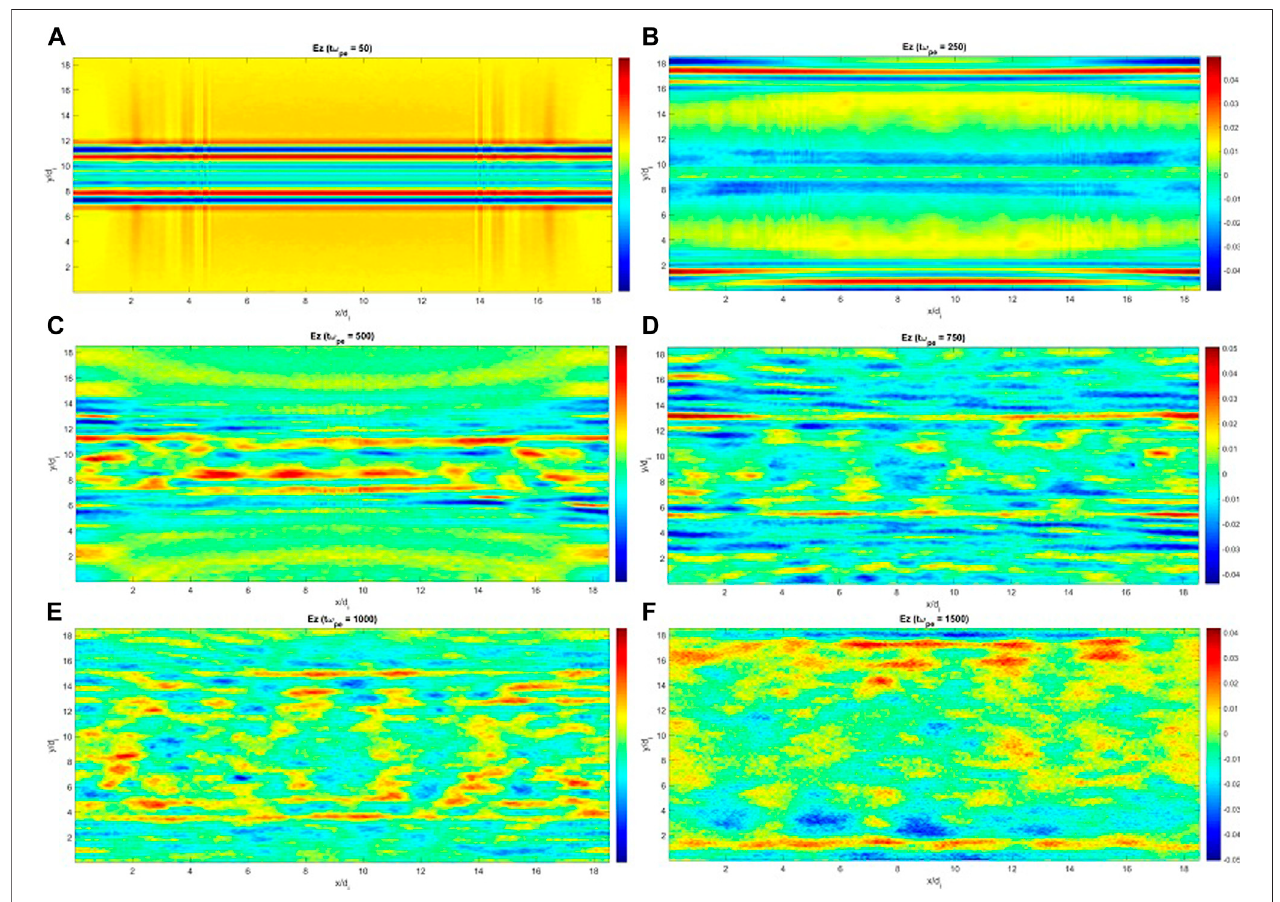
FIGURE 4 | E z component of the electric fi eld at times: t ω pe (cid:1) 50 (A) , 250 (B) , 500 (C) . 750 (D) , 1,000 (E) , 1,500 (F) with b z 0 (cid:1) 0.3 B 0 .